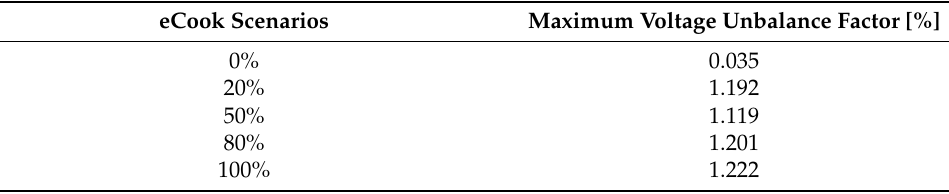
Table 3. Maximum voltage unbalance factor [%] for different eCook